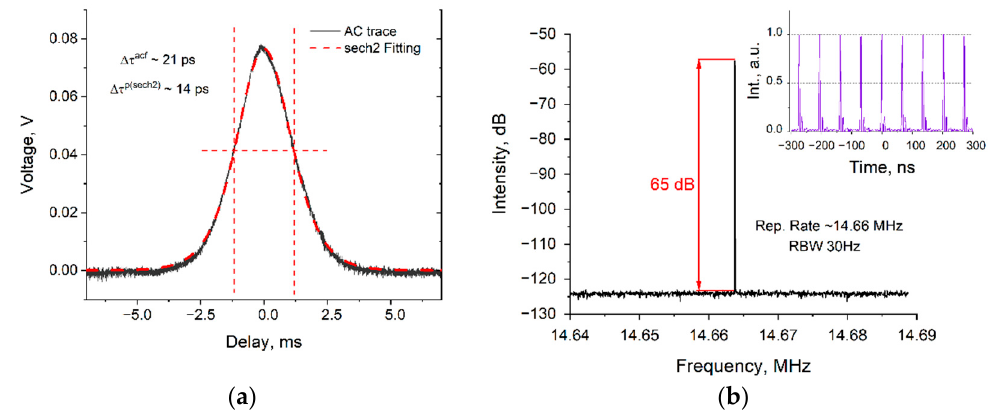
Figure 3 Autocorrelation trace and sech2 fitting ( a ). The RF spectrum (inset: laser pulse train) ( b